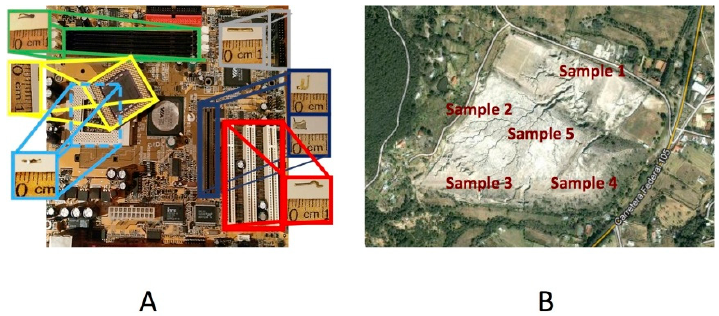
Figure 1. Image of the samples used for the leaching of ( A ) WEEE and ( B ) MW.